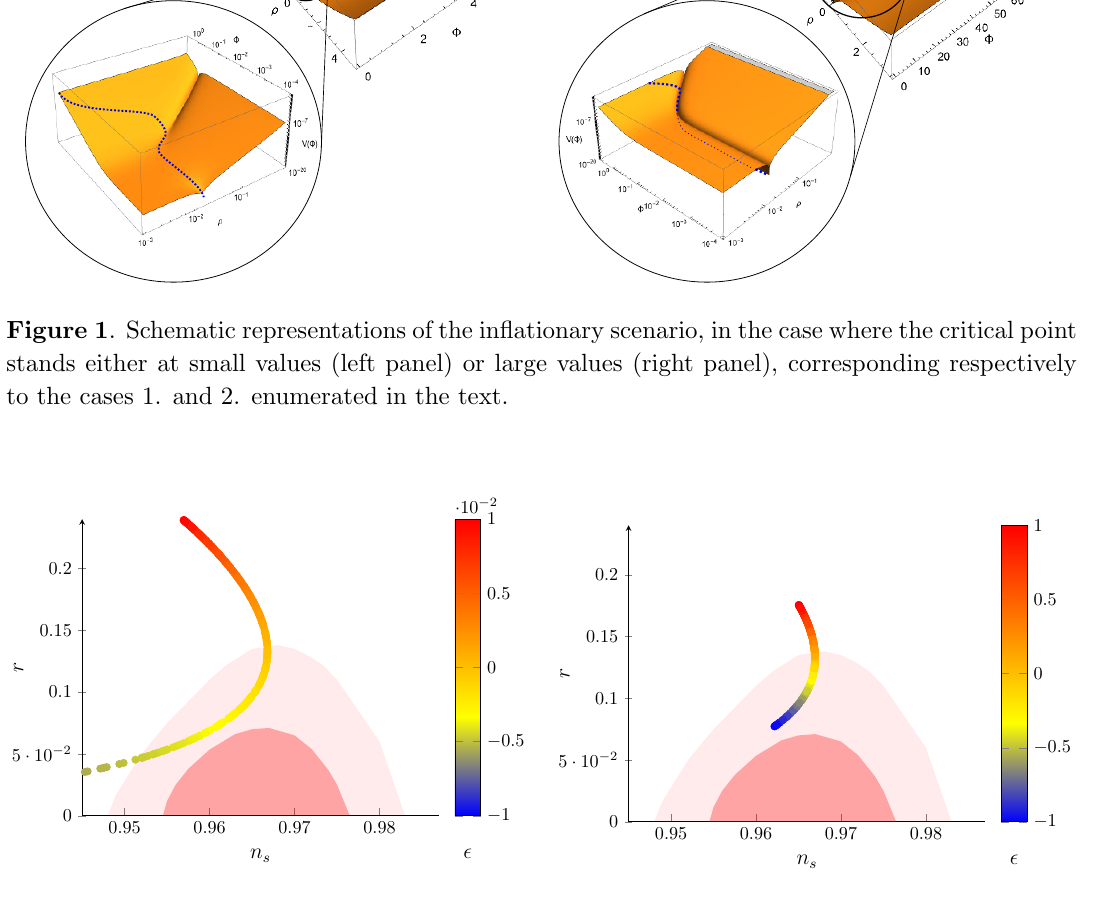
(cid:15) < 1 in the space of observables j j